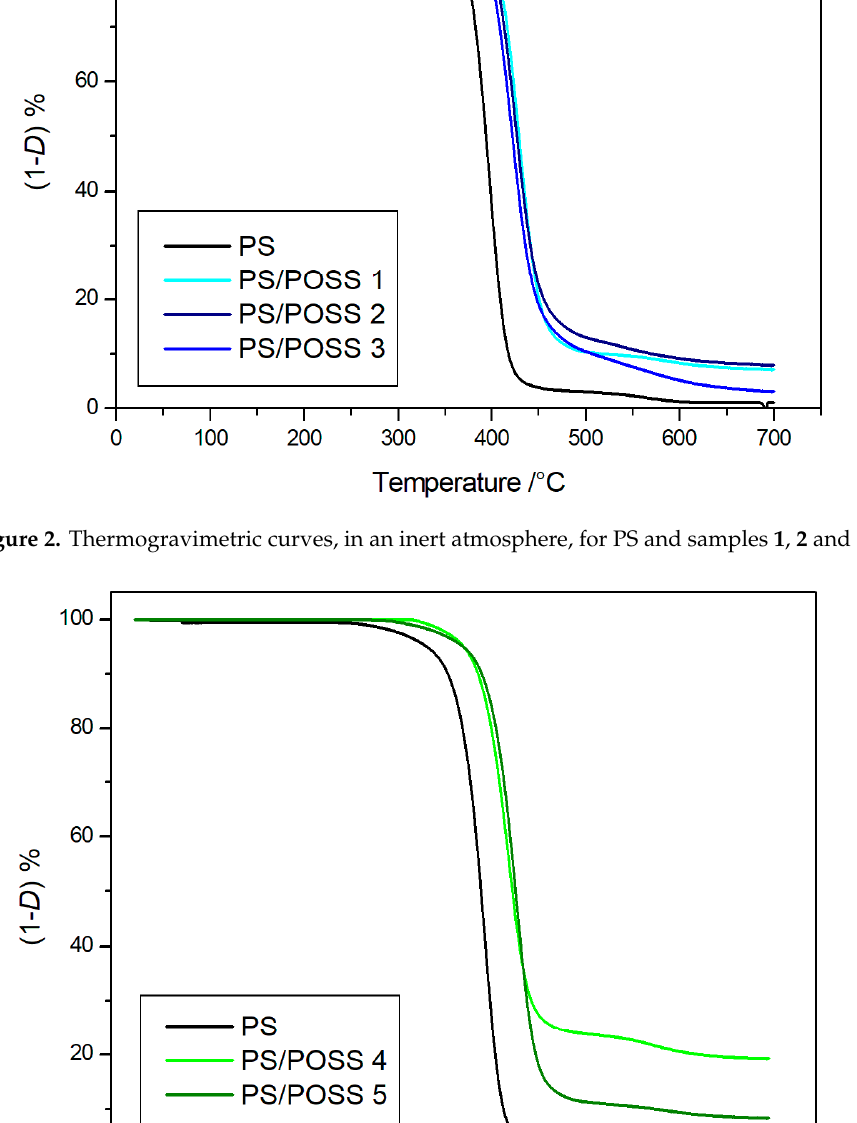
Polymers 2019 , x , x FOR PEER REVIEW 6 of 13